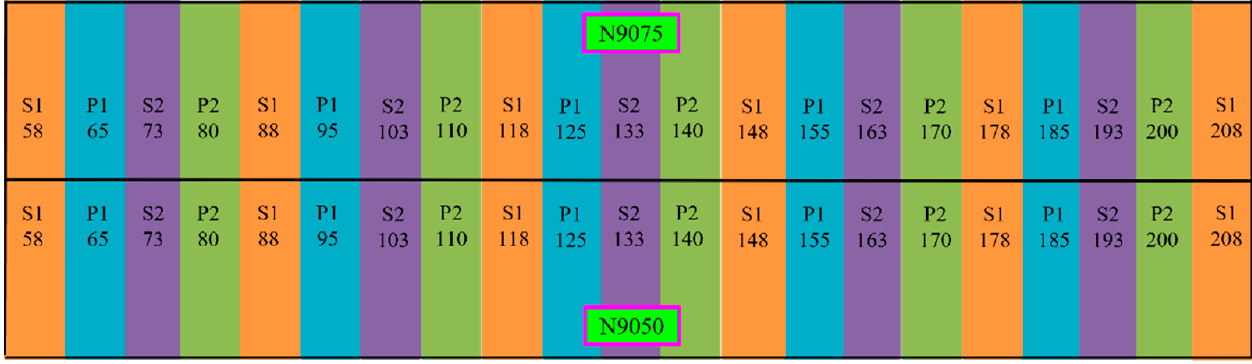
Figure 4. The stope mining sequence in the example two levels.